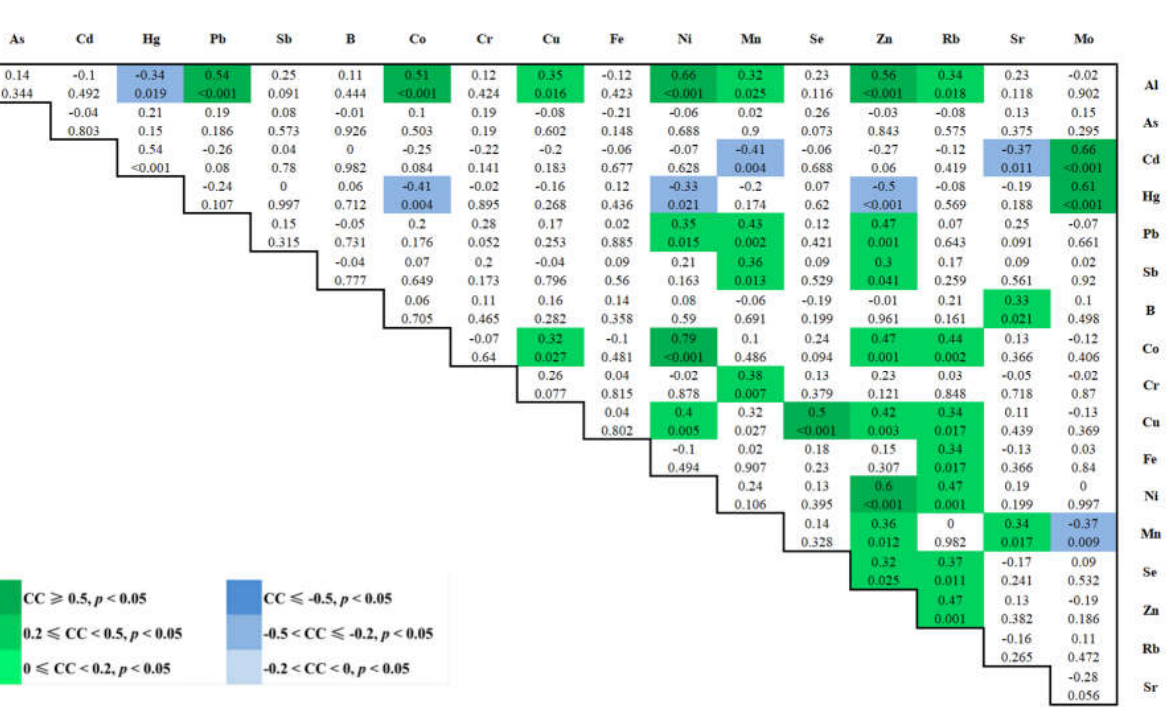
Figure 3. Color map of the Spearman correlations between 18 elements in maternal blood at 3rd trimester.